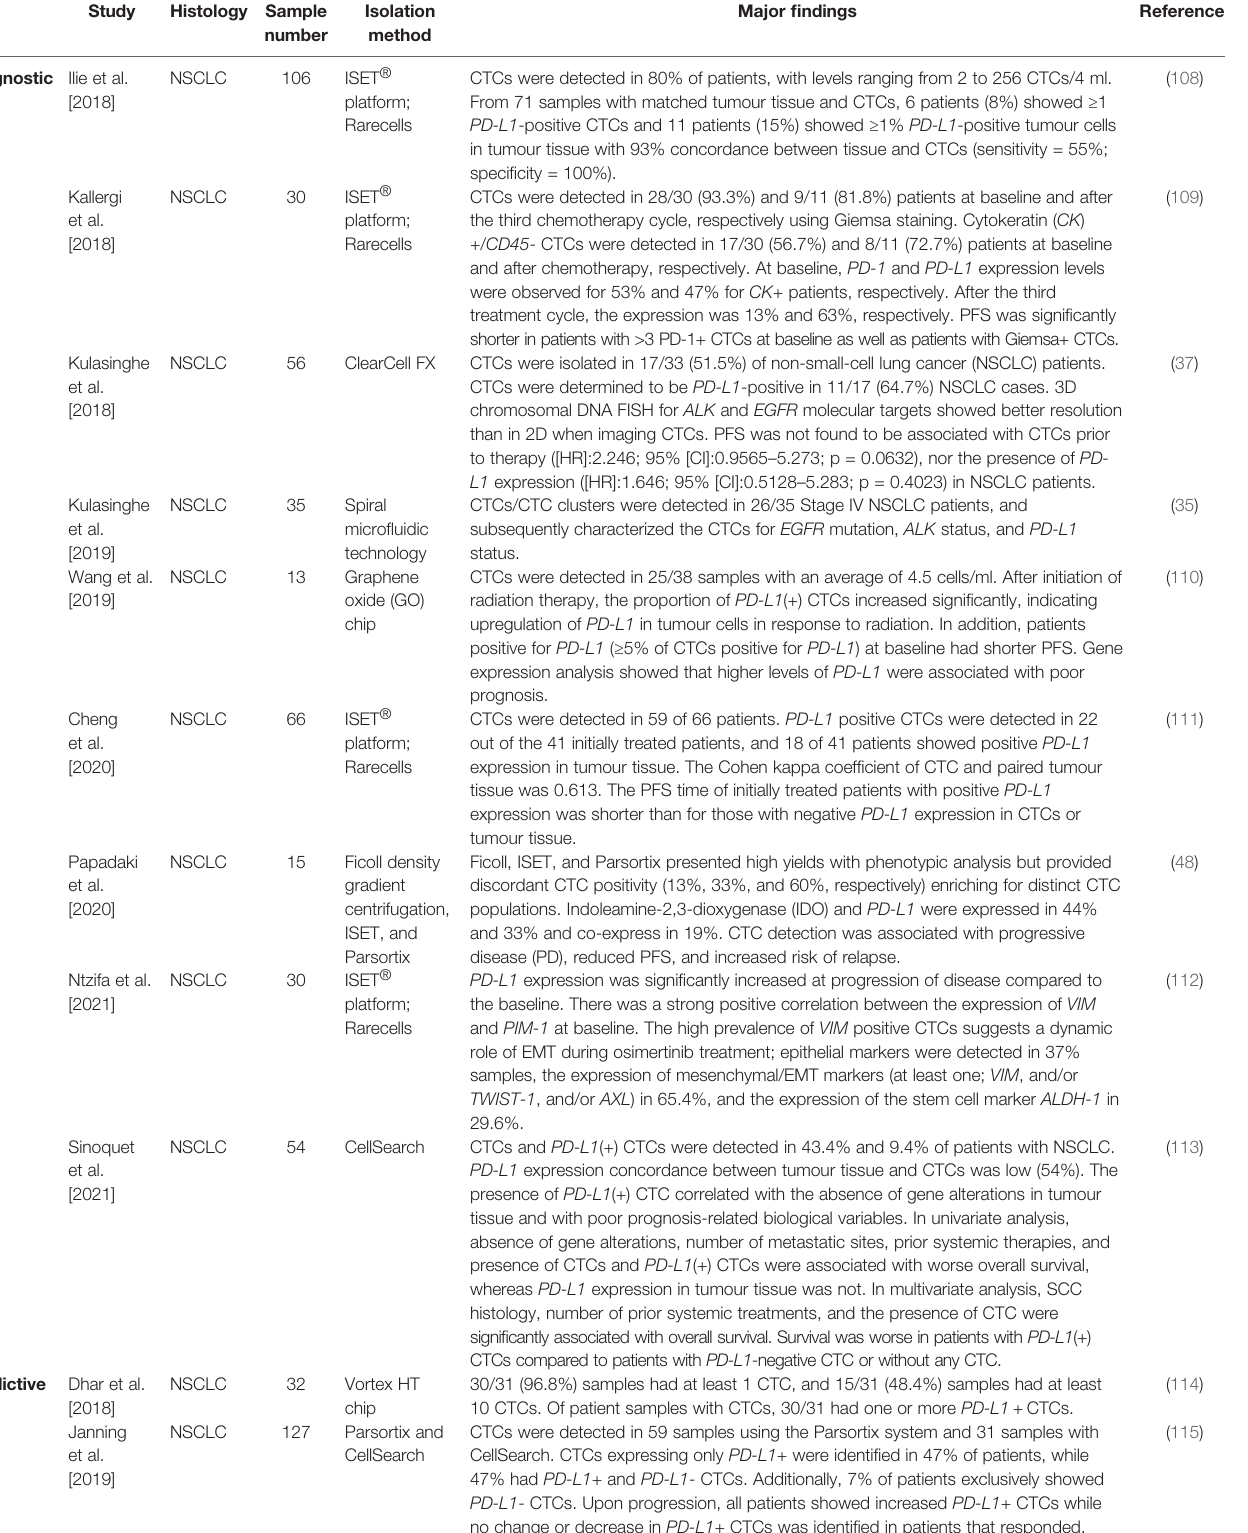
TABLE 2 | Recent studies evaluating the expression of PD-L1 on lung cancer-derived circulating tumour